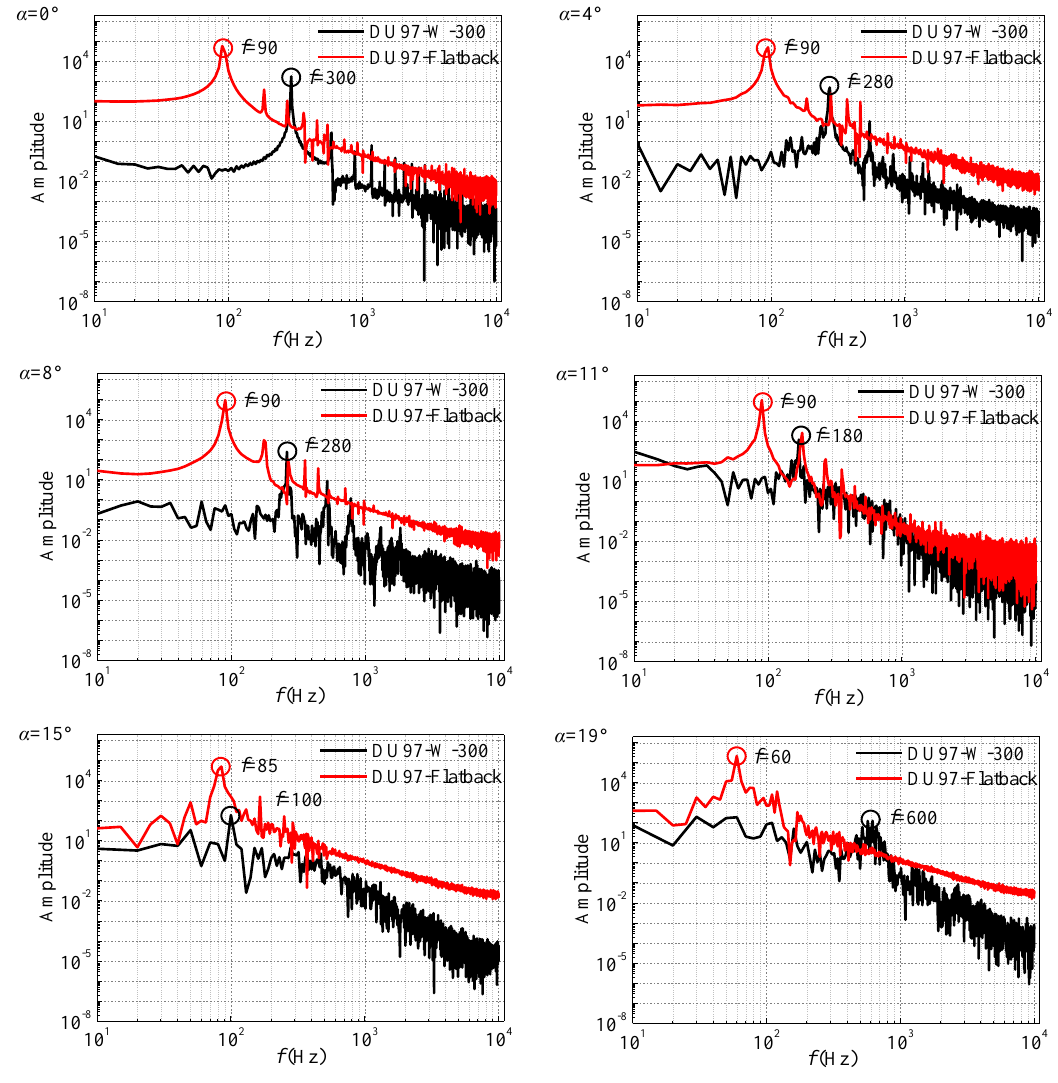
Figure 10. Power spectra of lift and drag coefficient.